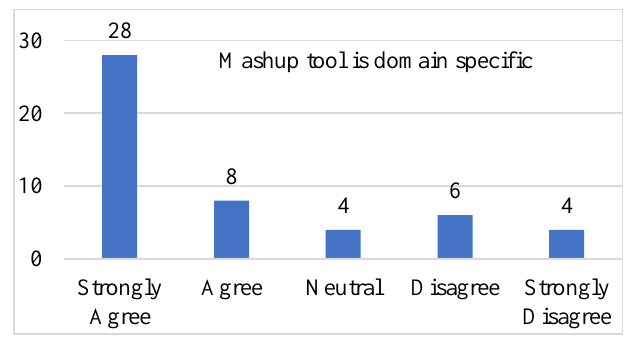
Fig. 6. Main purpose of UML in IoT